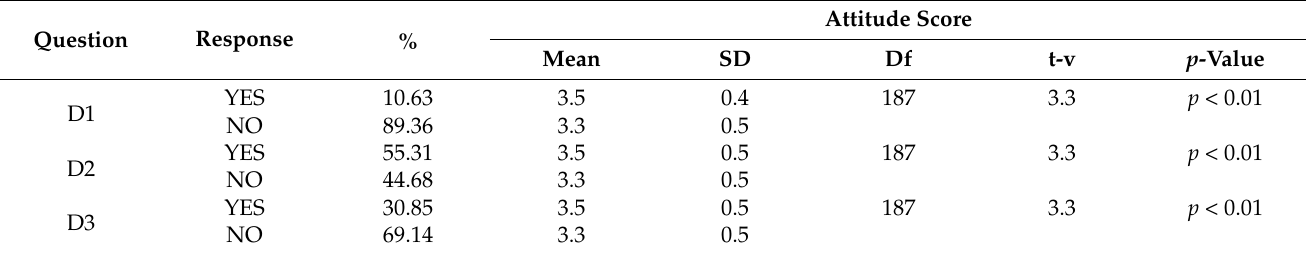
Table 8. Students’ attitude scores according to their marine-related course experience, marine recre- ational activities, and conservation activities. Appendix A, part E provides details about questions D1, D2, and D3. Independent sample t -test represents significant differences among students’ attitude scores regarding their responses for questions D1, D2, and D3. t-v indicates